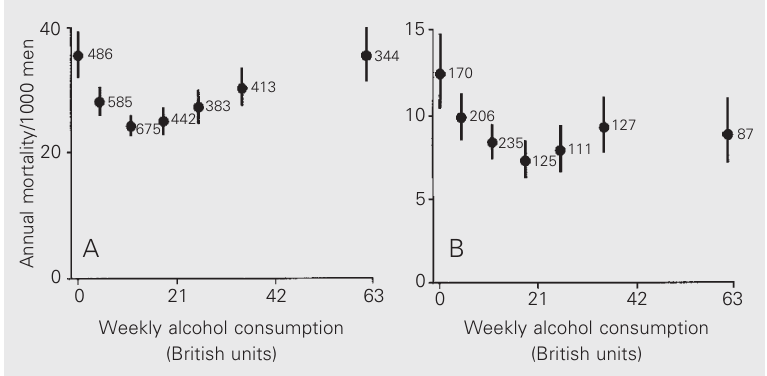
Figure 1. The U-shaped curve for all causes (A) and ischemic heart disease (B) mortality in British doctors in relation to alcohol consumption. British units = 9 g alcohol (or equivalent). Modified from Ref. 8, with